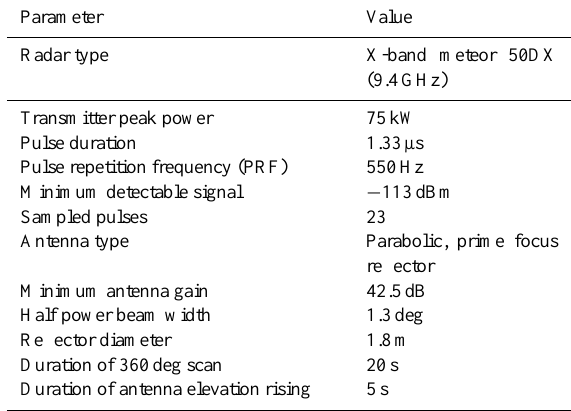
Table 1. Technical specifications of the DPX radar used for the anal- ysed case study during Grímsvötn 2011.